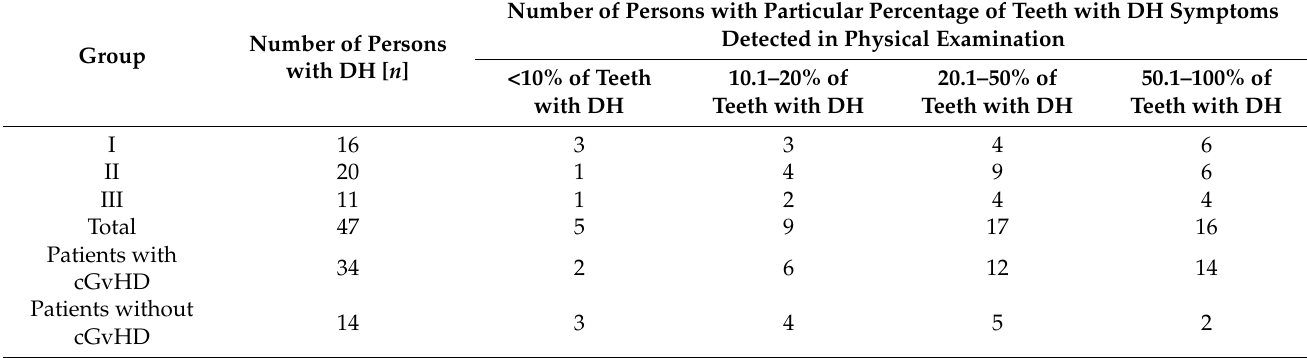
Table 5. Percentage of teeth with dentin hypersensitivity symptoms detected in a physical examination.